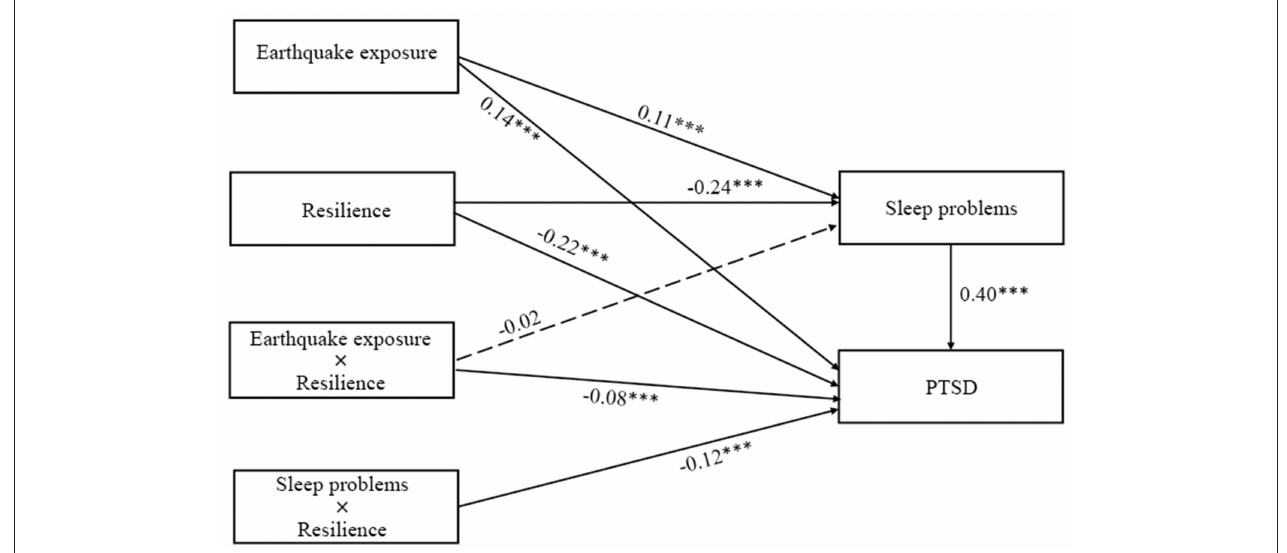
FIGURE 4 | The moderating effect of resilience on the indirect relationship between earthquake exposure and PTSD symptoms.